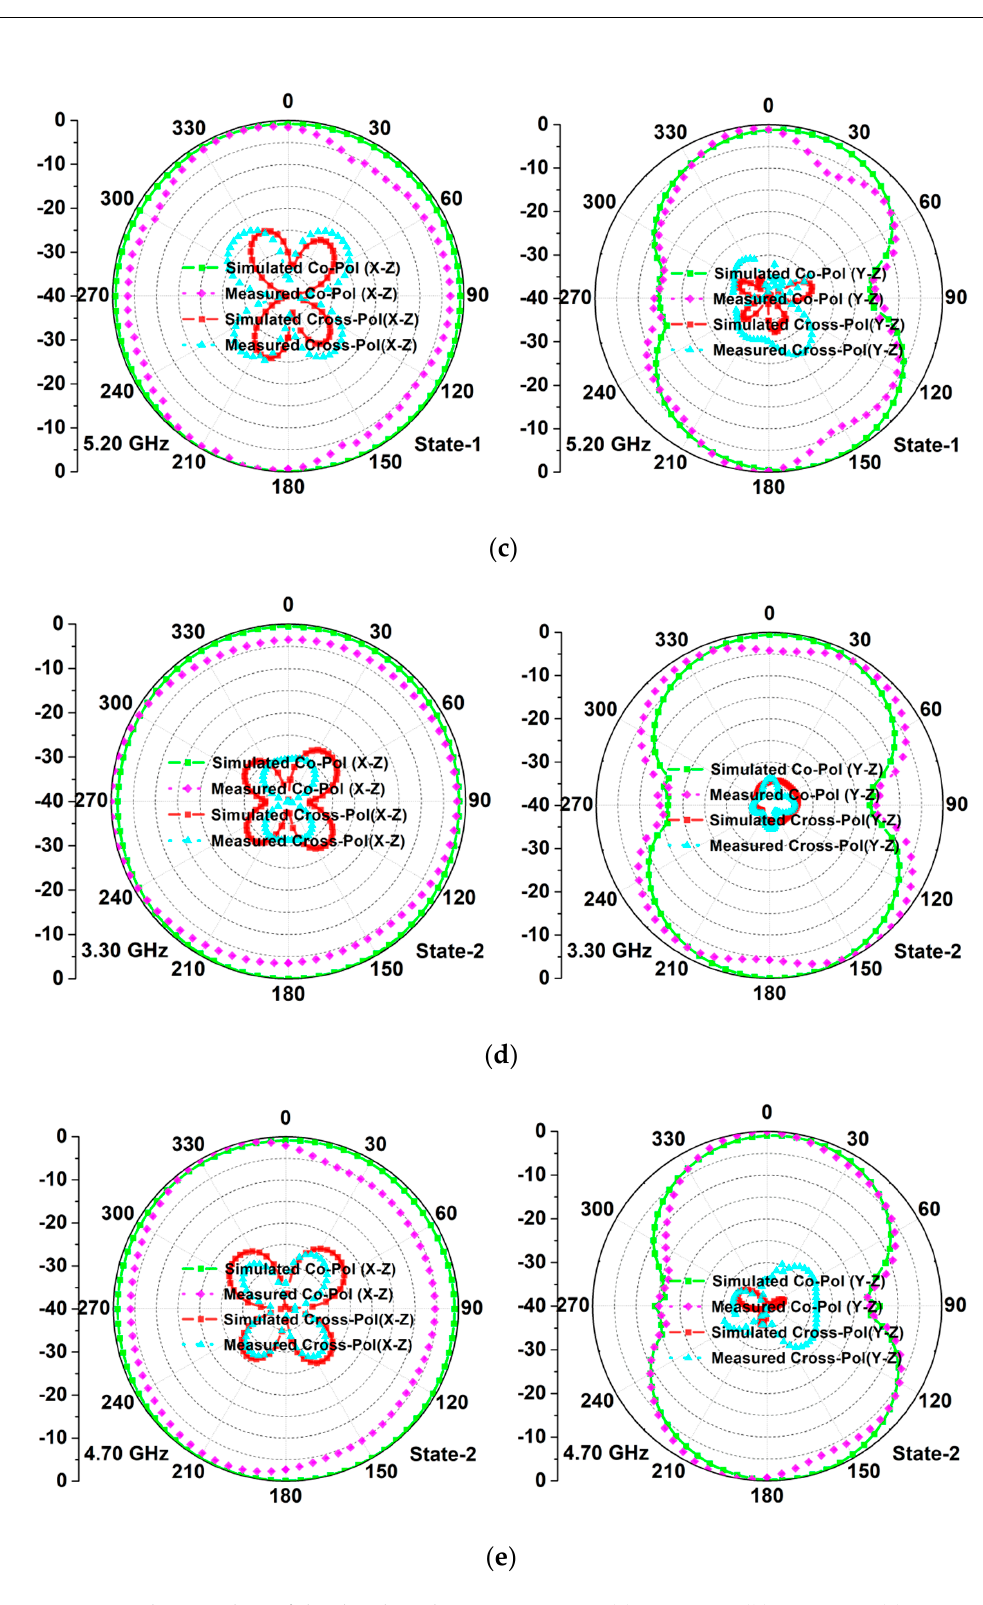
Figure 9. Radiation plots of the developed MIMO antenna: ( a ) 2.50 GHz; ( b ) 3.50 GHz; ( c ) 5.20 GHz; ( d ) 3.30 GHz; ( e ) 4.70 GHz.